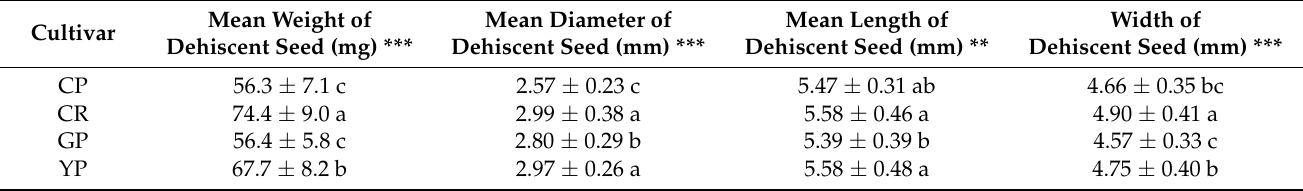
Table 3. Characteristics of dehiscent seeds depending on the cultivar of P. ginseng after stratification treatment for 90 days.